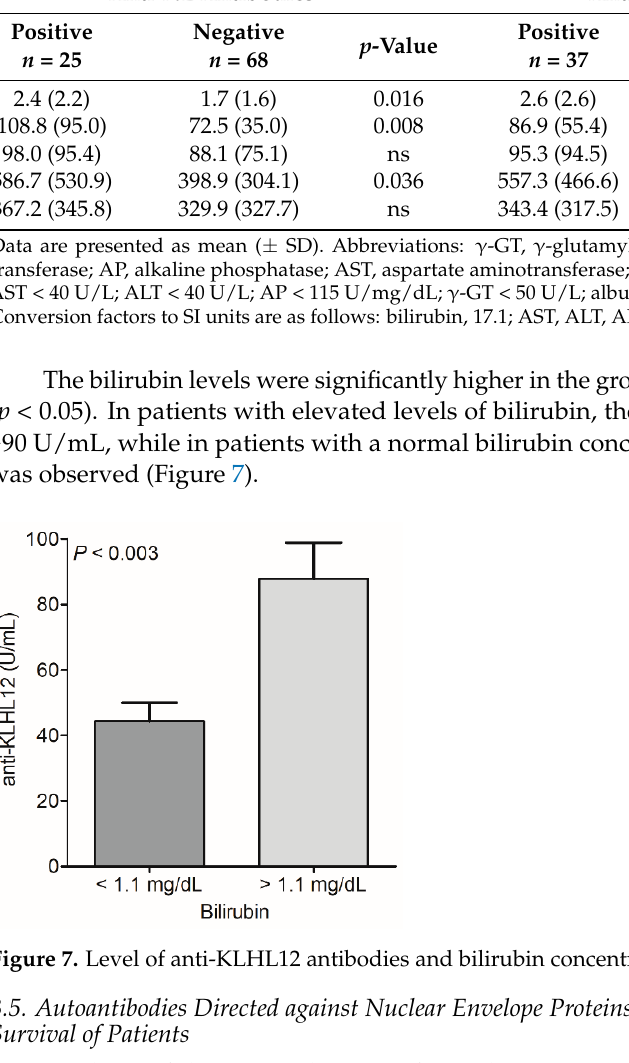
Table 4. Data from biochemical analyses of 138 PBC patients, and the anti-NE and anti-KLHL12